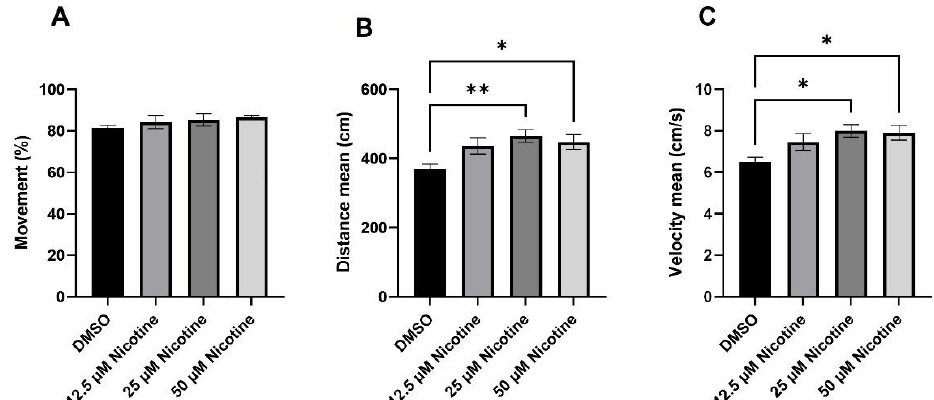
Figure 9. Embryonic nicotine exposure increases locomotion activity in zebrafish adults. Bars represent ( A ) percentage of time the fish is moving, ( B ) the total distance traveled, and ( C ) velocity, during the first 10 min of the behavioral session without stimulus. Embryonic nicotine exposure at 25 µM and 50 µM increases distance traveled and velocity, but does not affect the movement percentage. * = p < 0.05; ** = p < 0.01.